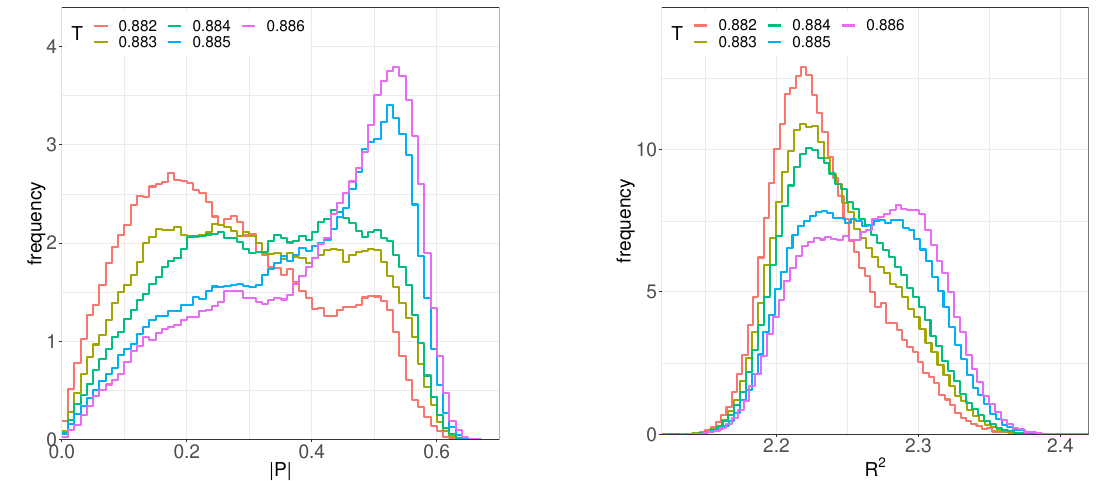
Figure 24. Histogram of the order parameter j P j and the matrix size R 2 close to the transition temperature for the D = 10 theory. Simulations are performed at N = 32, L = 24 and various